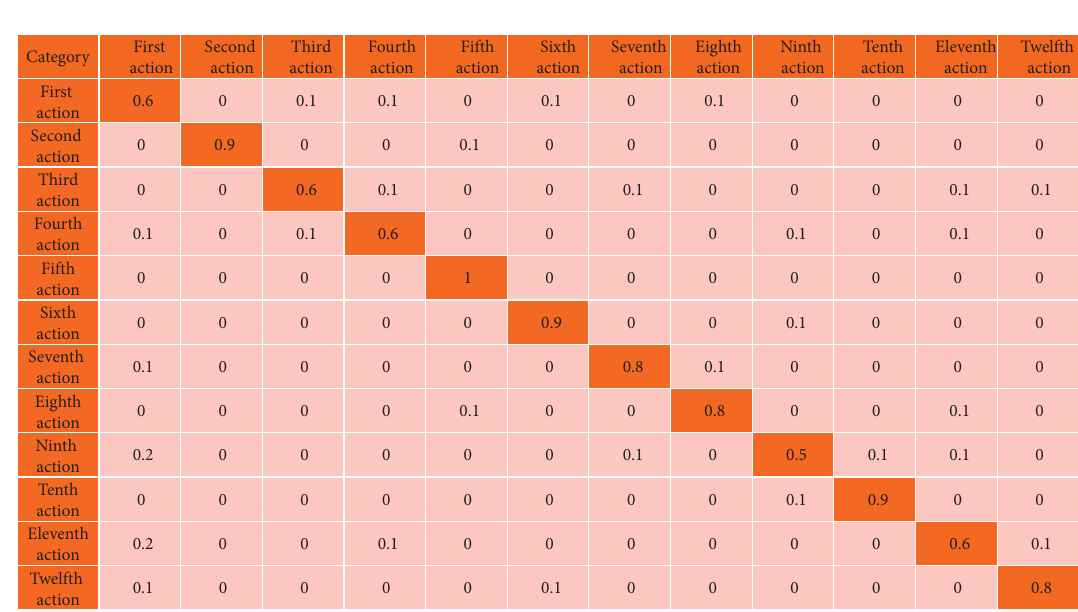
Figure 9: Confusion matrix of CNN in Exercise A.